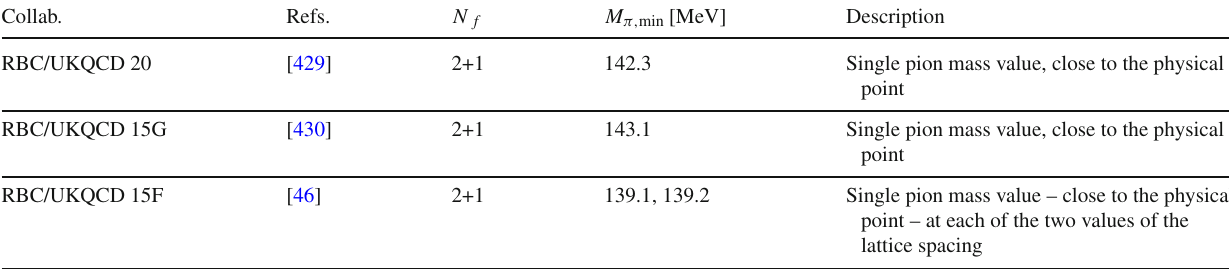
Table 123 Finite volume effects in determinations of the K → ππ decay amplitudes Collab.